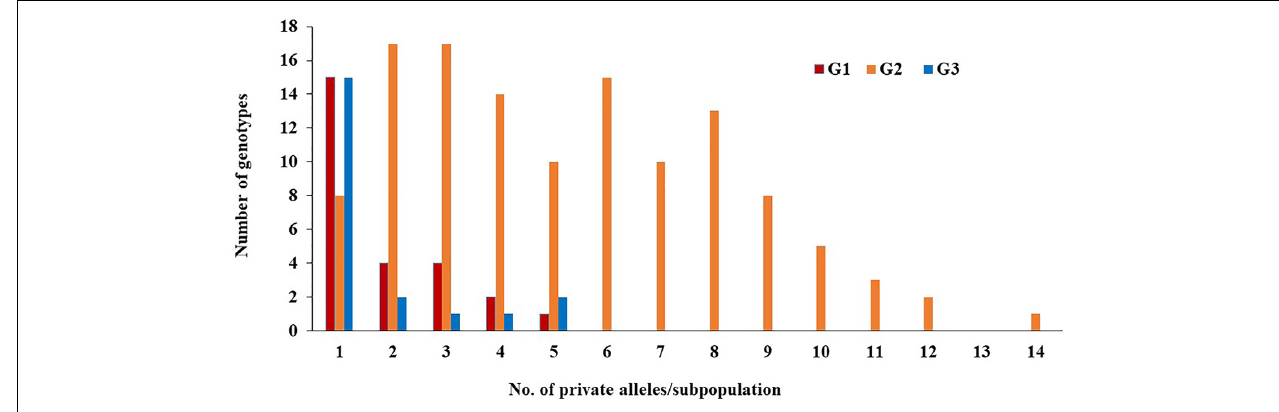
FIGURE 5 | Number of private alleles in each subpopulation (G).